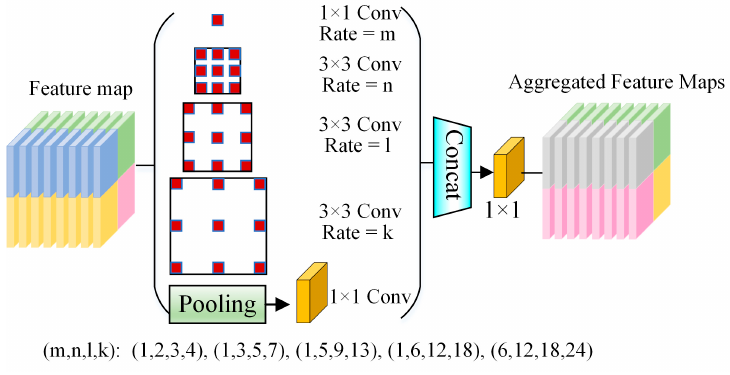
Figure 5. Structure of the ASPP module.